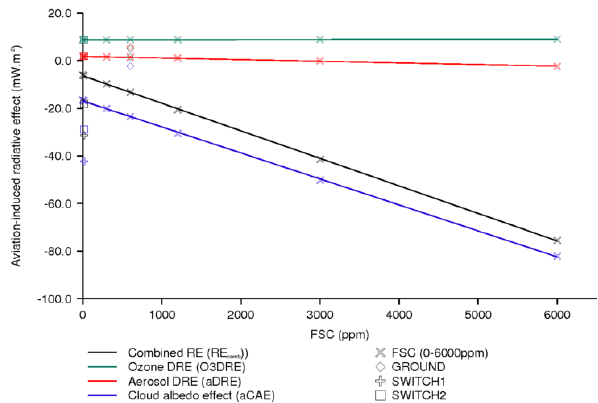
Figure 10. Relationship between net radiative effect (sum of ozone direct (O3DRE), aerosol direct radiative (aDRE) and aerosol cloud albedo (aCAE) effects) and annual mortality rates: for low- mid- and high-range mortality